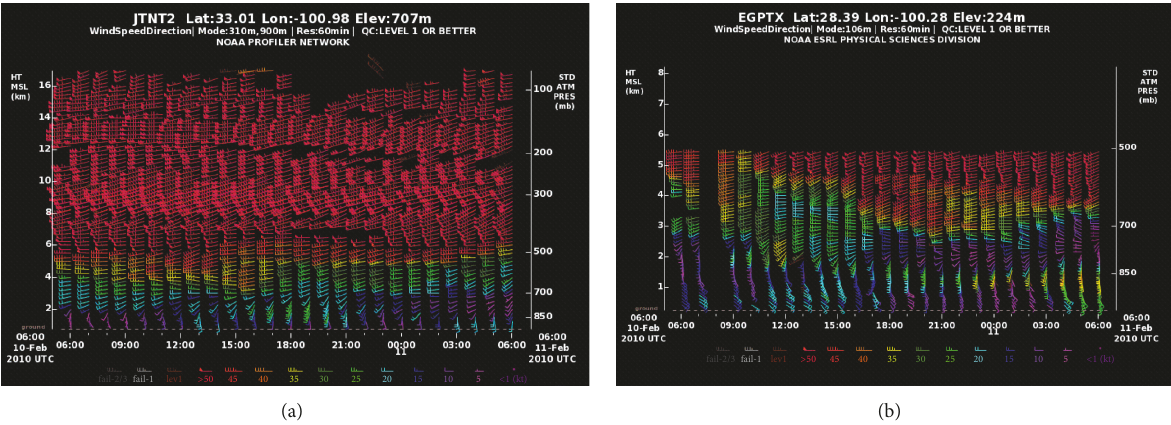
Figure 8: NOAA wind profilers (in knots) for (a) Jayton, Texas, and (b) Eagle Pass, Texas, valid from 0600 UTC 10 February to 0600 UTC 11 February